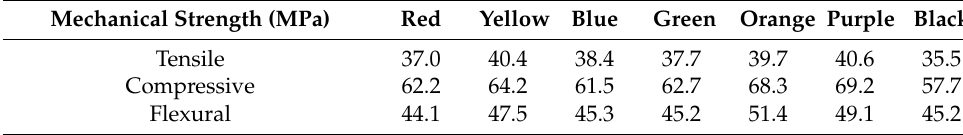
Table 8. Average mechanical strengths of colored PLA samples from Rambery ®